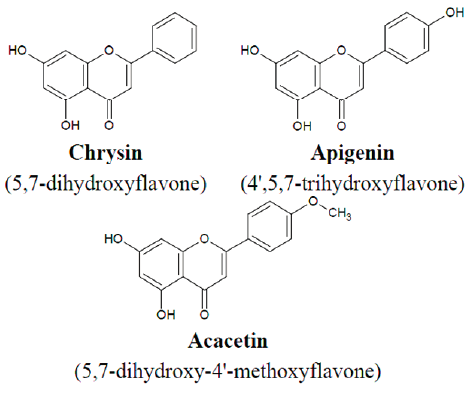
Figure 1. Chemical structure of tested flavones.